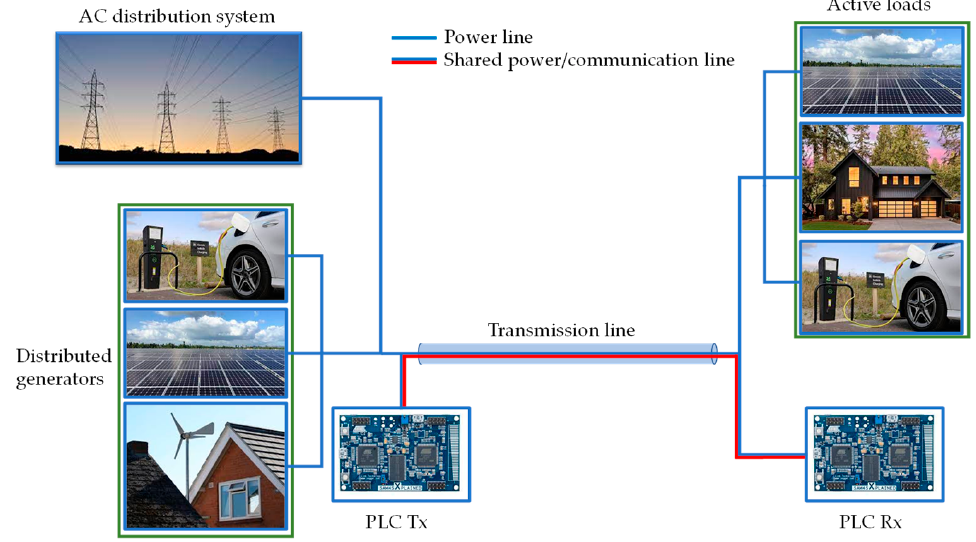
Figure 1. Schematic representation of a typical PLC application in modern distribution systems.